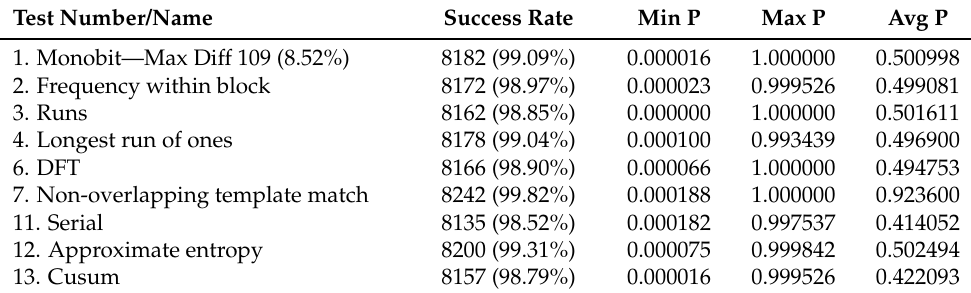
Table 2. Test results for potential weak keys (8257 samples total).